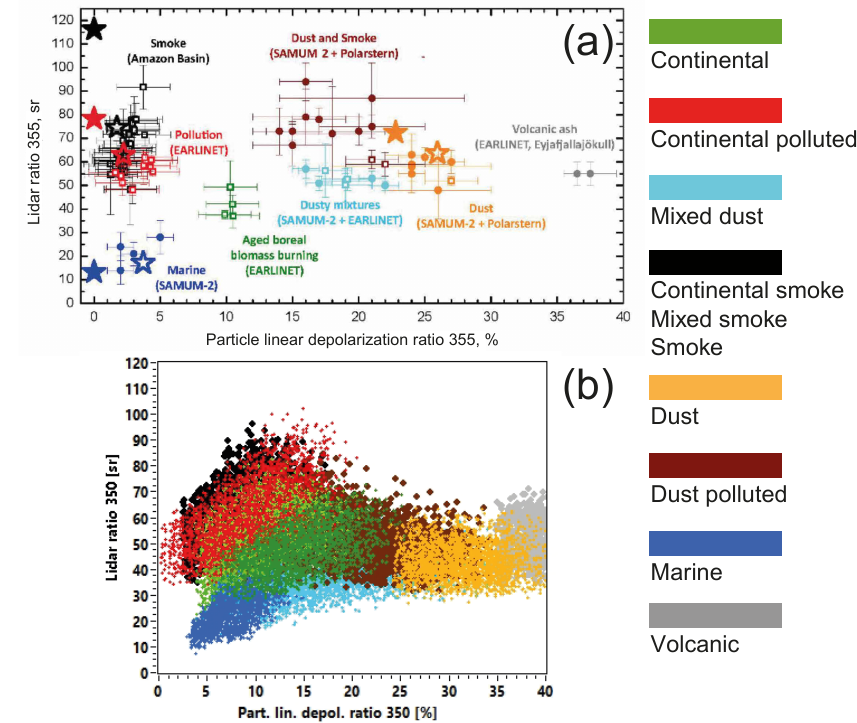
Figure 5. Lidar ratio versus particle linear depolarization ratio. (a) Synthesis of ground-based observations and simulations adapted from Wandinger et al. (2016) (their Fig. 1). Filled stars represent simulations using the components of Aerosol CCI and variations with different refractive indexes and shape distributions (open stars). (b) Synthetic data from the NATALI aerosol